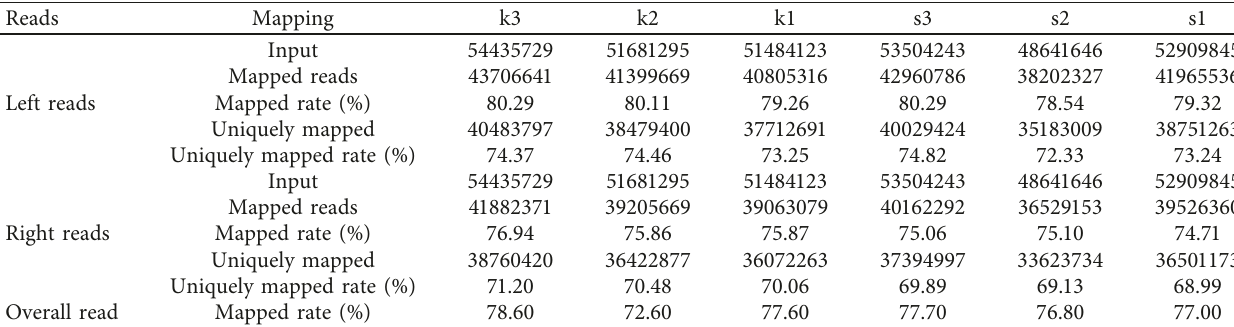
Table 2: The results of sequence